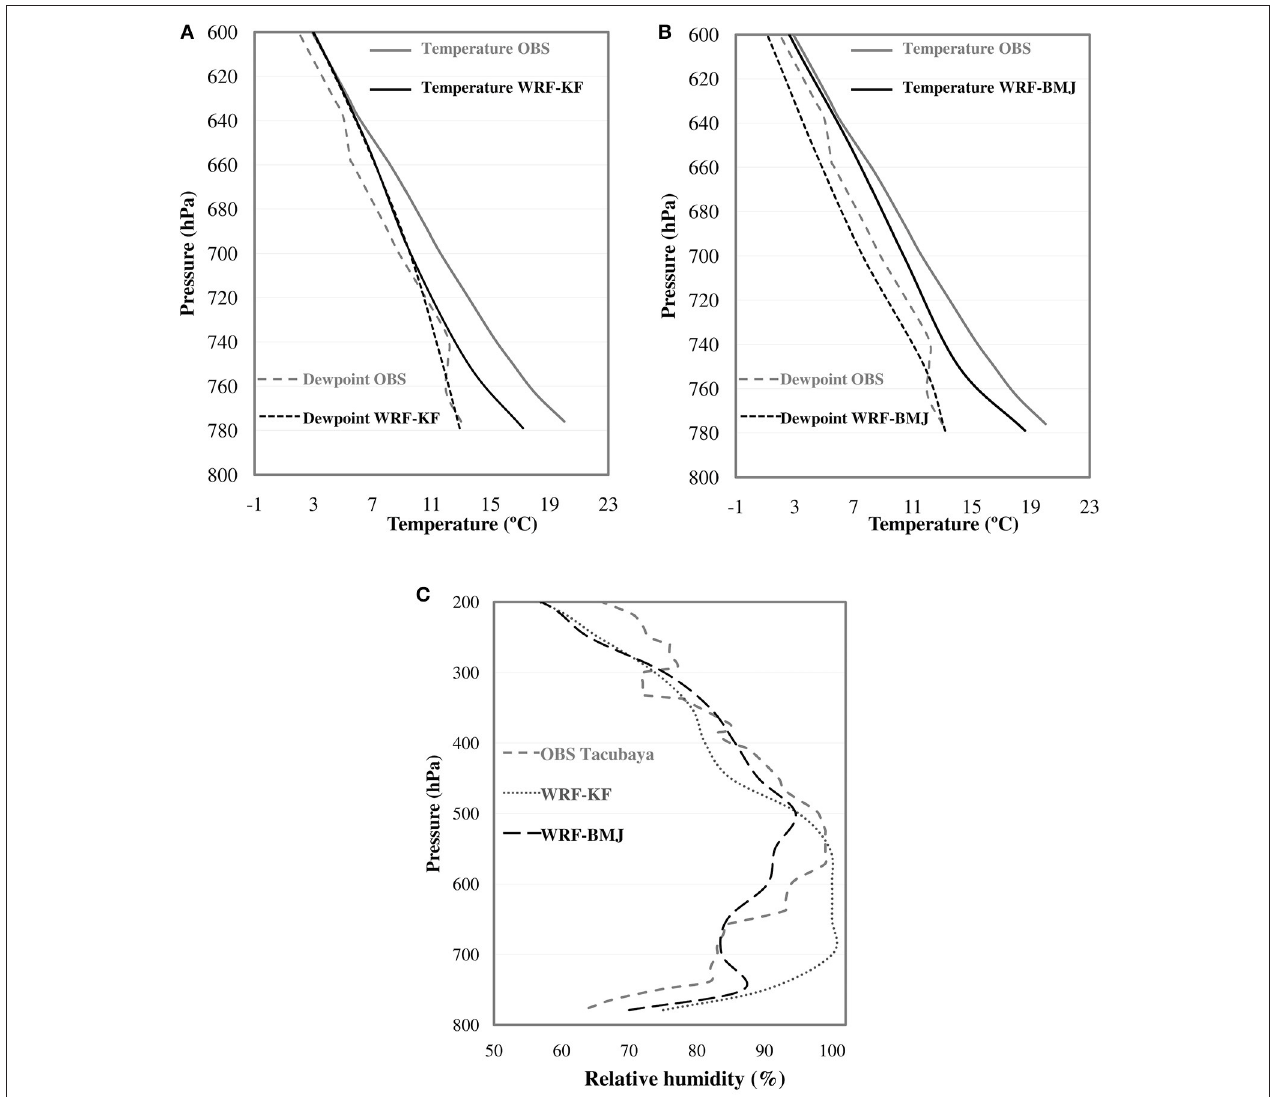
FIGURE 11 | Vertical profiles at 00:00 UTC 17 July 2014; (A) Air temperature ( ◦ C) (solid line) and dew point temperature ( ◦ C) (dashed line). Tacubaya radiosonde (gray), WRF sounding using the KF convection scheme (black); (B) Tacubaya radiosonde, WRF sounding using the BMJ convection scheme (black); (C) Relative humidity profile (%). Tacubaya radiosondeo (gray dashed), WRF-BMJ scheme (black) and WRF-KF scheme (gray dots).